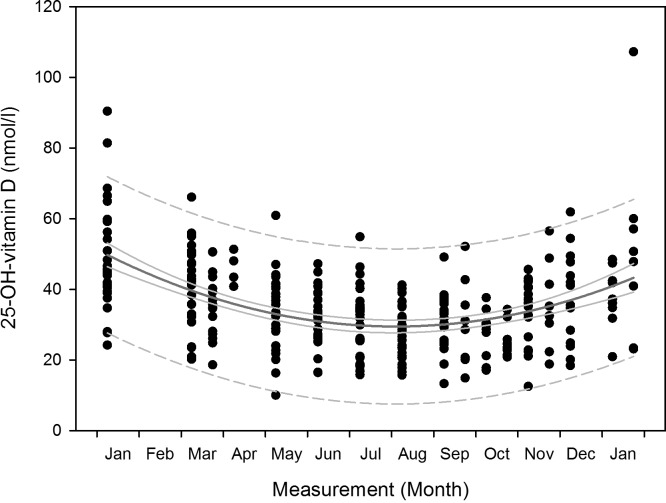
25-OH-vitamin D serum concentrations 2007–2012: Scatterplot per two-week measurement and nonlinear regression curve.Changes of 25-OH-vitamin D serum concentrations from 2007 to 2012, scatterplot per two-month measurement for all participants (refer to Table 3 for n per month) with nonlinear regression curve (dark grey curve), 95% confidence intervals (light grey curve) and 95% prediction intervals (dashed grey curve).